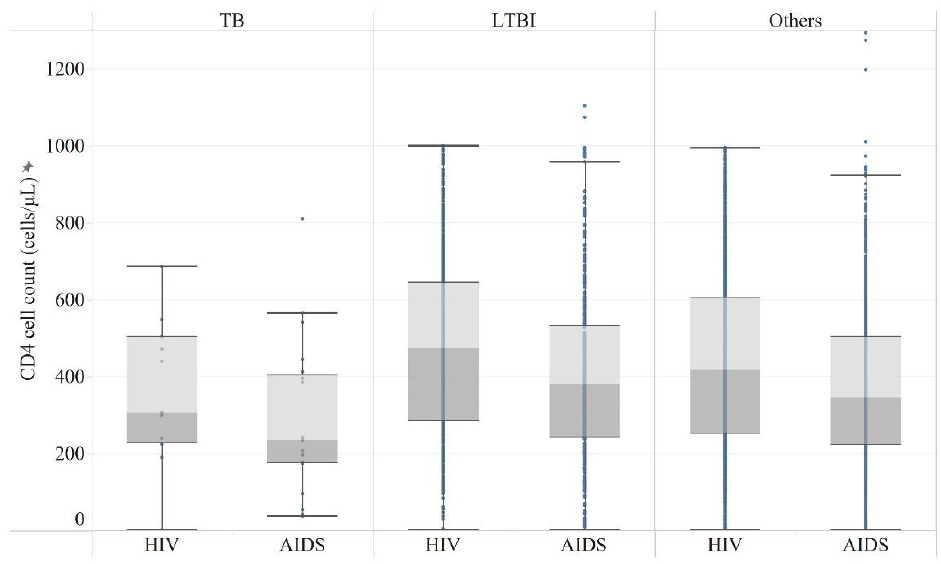
Figure 3. CD4 cell count of HIV/AIDS outpatients in Guangxi Province.